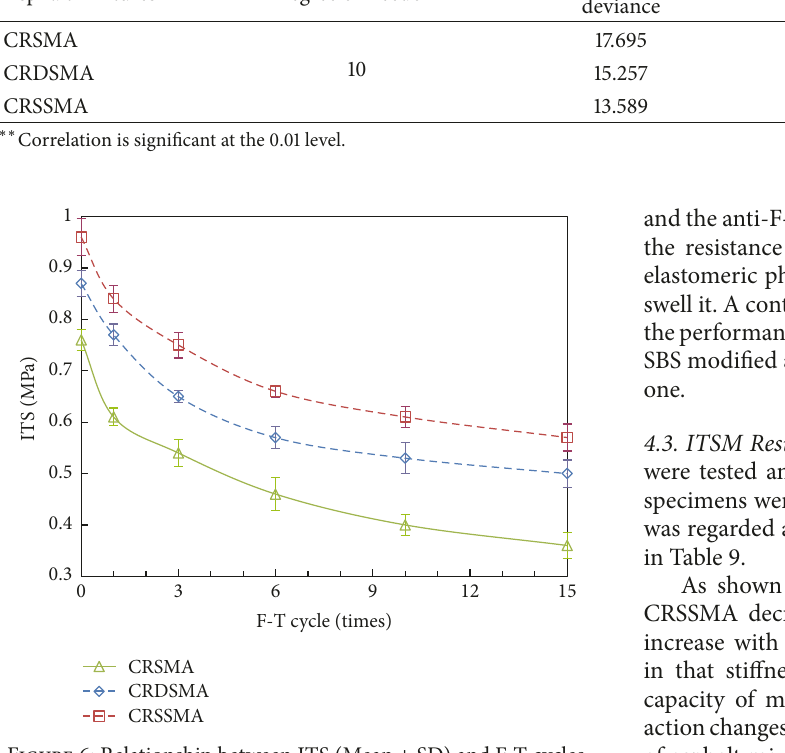
Figure 6: Relationship between ITS (Mean ± SD) and F-T cycles.